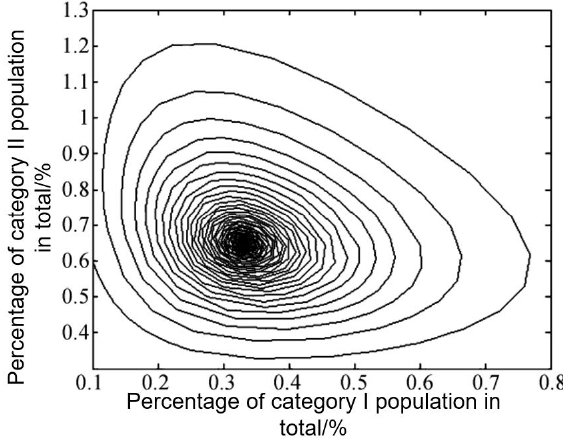
Fig. 2 Plane phase diagrams of I and II groups of people